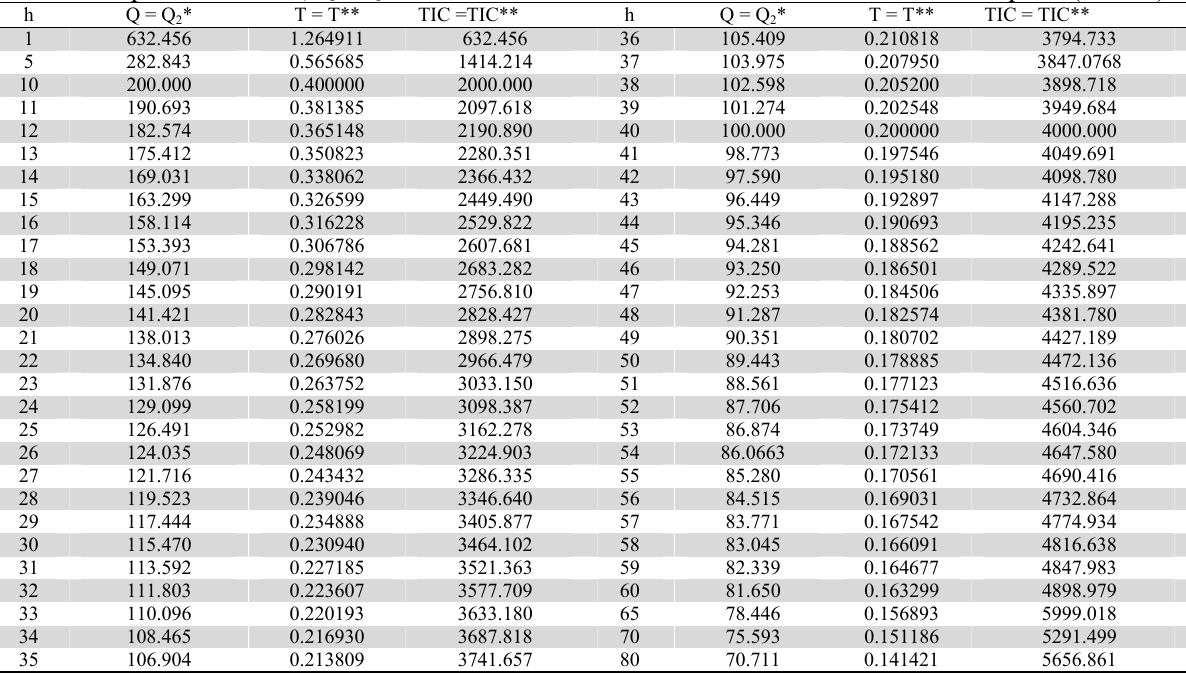
Values of optimal T = T**, Q = Q * and TIC = TIC** for different values of ‘h’ for example 2 (Case 2